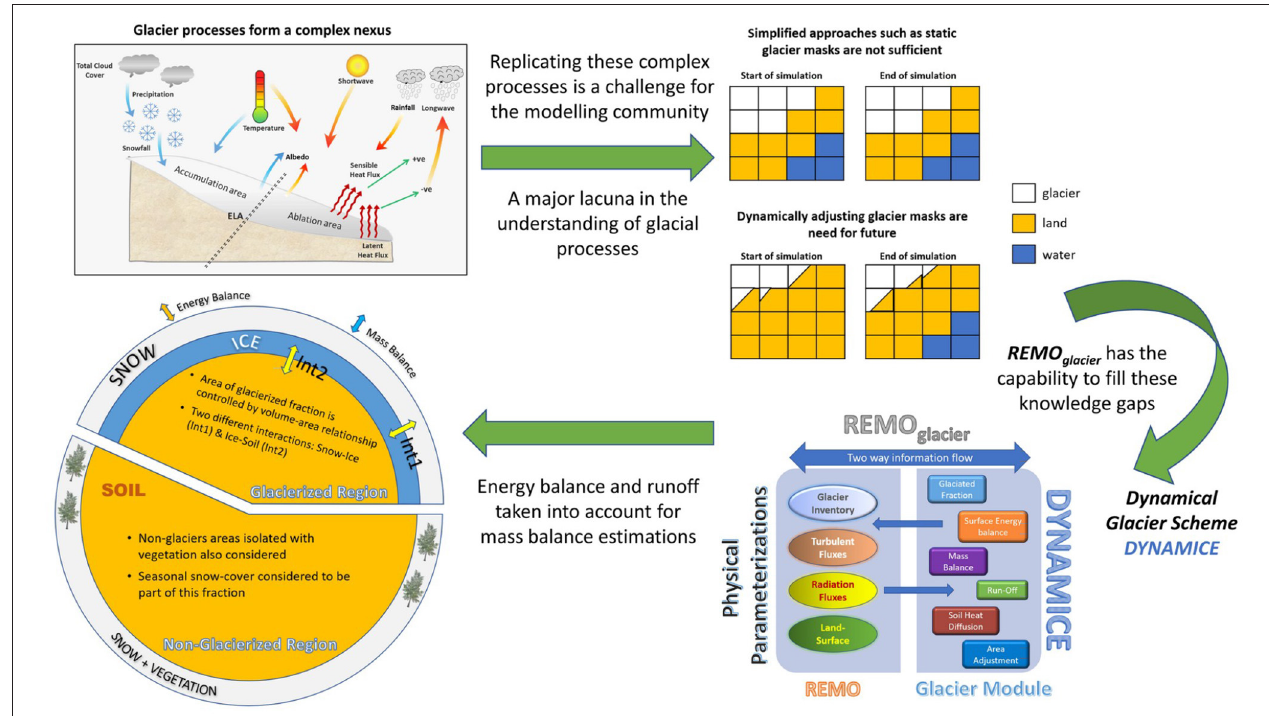
FIGURE 3 | A schematic representation of the complex glacial processes involved in mass-balance estimations (top left). The difference in simplified (static glacier masks) and sophisticated (dynamical glacier masks) approaches (top right). Description of the dynamical glacier scheme DYNAMICE and the regional model dynamics of REMO glacier (bottom right). Different model dynamics and parameterisation schemes operate separately for glacierised and non-glacierised regions (bottom